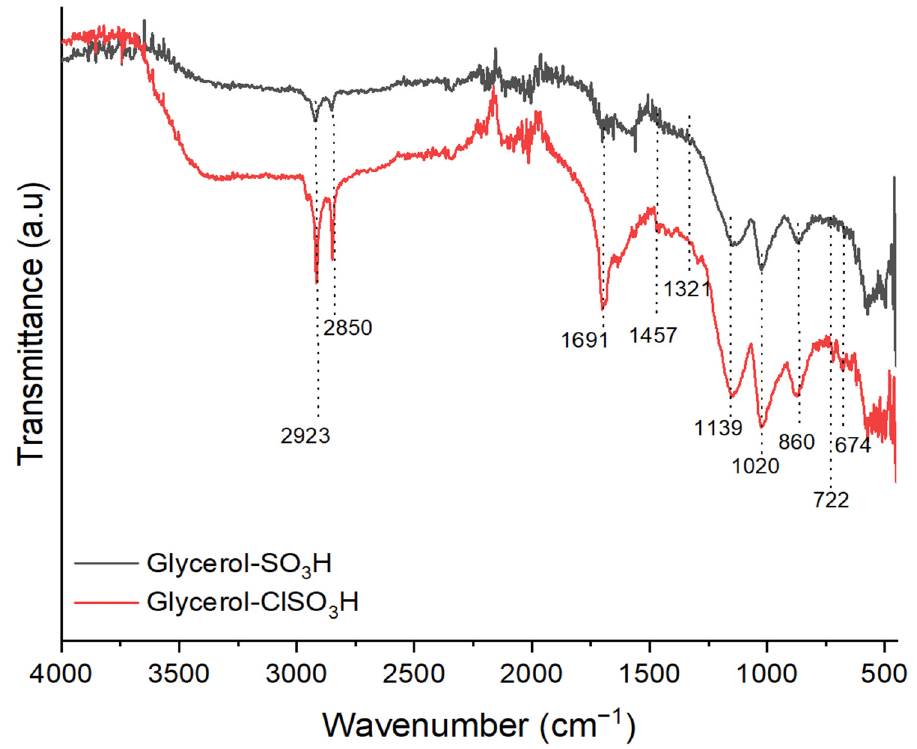
Figure 3. Infrared absorption spectra of glycerol-SO 3 H and glycerol-ClSO 3 H catalyst.